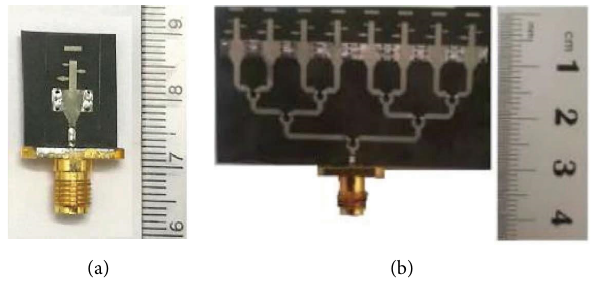
Figure 4: (a) Single element. (b) Antenna array [13].